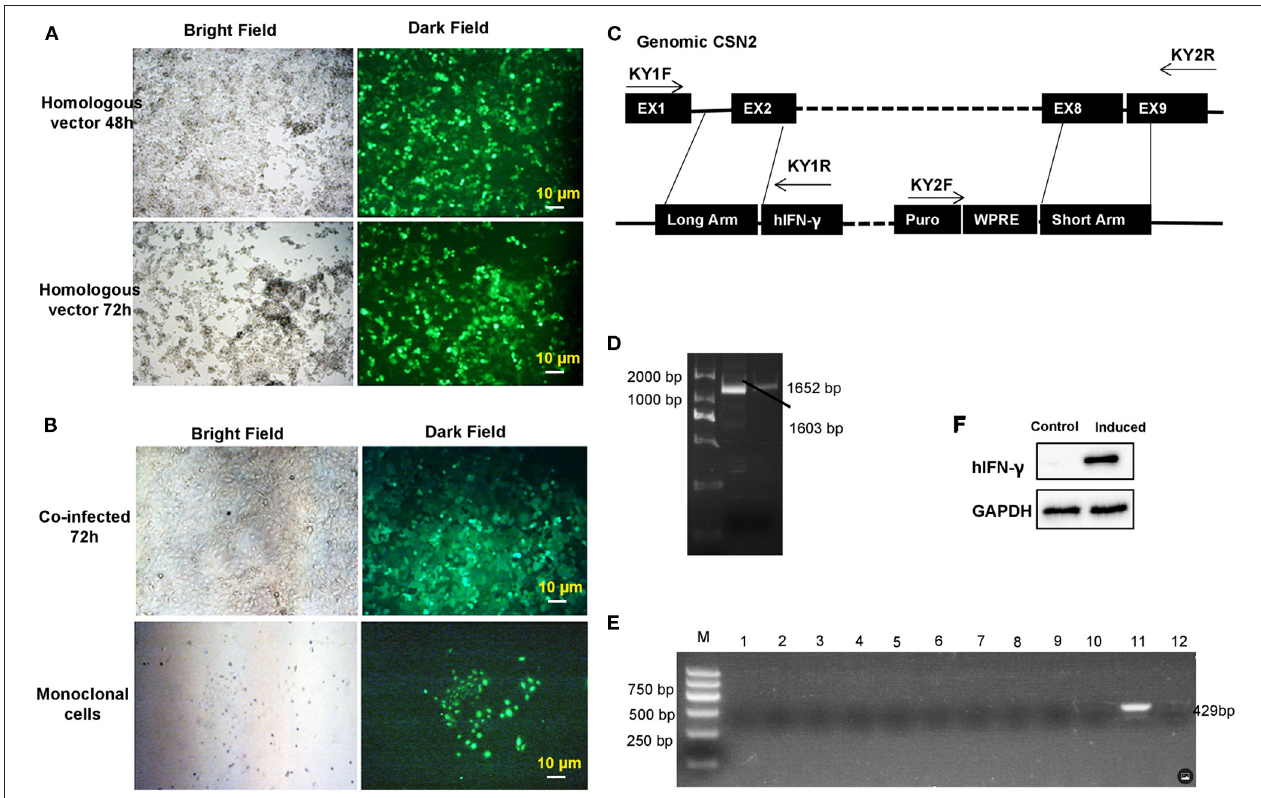
FIGURE 3 | Transgenic monoclonal goat mammary gland epithelial cells (GMECs) screening and evaluation. (A) Lentivirus plasmids were packaged in 293T cells. Homologous and target vectors were all packaged in 293T cells. Expression of green fluorescent protein (GFP) in 293T cells confirmed that the infection rate of homologous vectors was sufficient for the virus concentration. (B) The monoclonal GMECs that were obtained after puromycin selection. (C,D) Integrated interferon-gamma (IFN- γ ) expression cassettes were evaluated by PCR assays. Inserted site detection indicated the expression cassettes were correctly integrated into the genome of GMECs. Middle lane (D) in the figure is the KY2 PCR product, the right lane (D) is KY1 PCR product. (E) Detection of IFN- γ mRNA in the monoclonal cells by RT-PCR after inducible expression. (F) Western blot analysis of inducible IFN- γ . Analysis of IFN- γ indicated that the gene-edited GMECs could secrete IFN- γ protein as